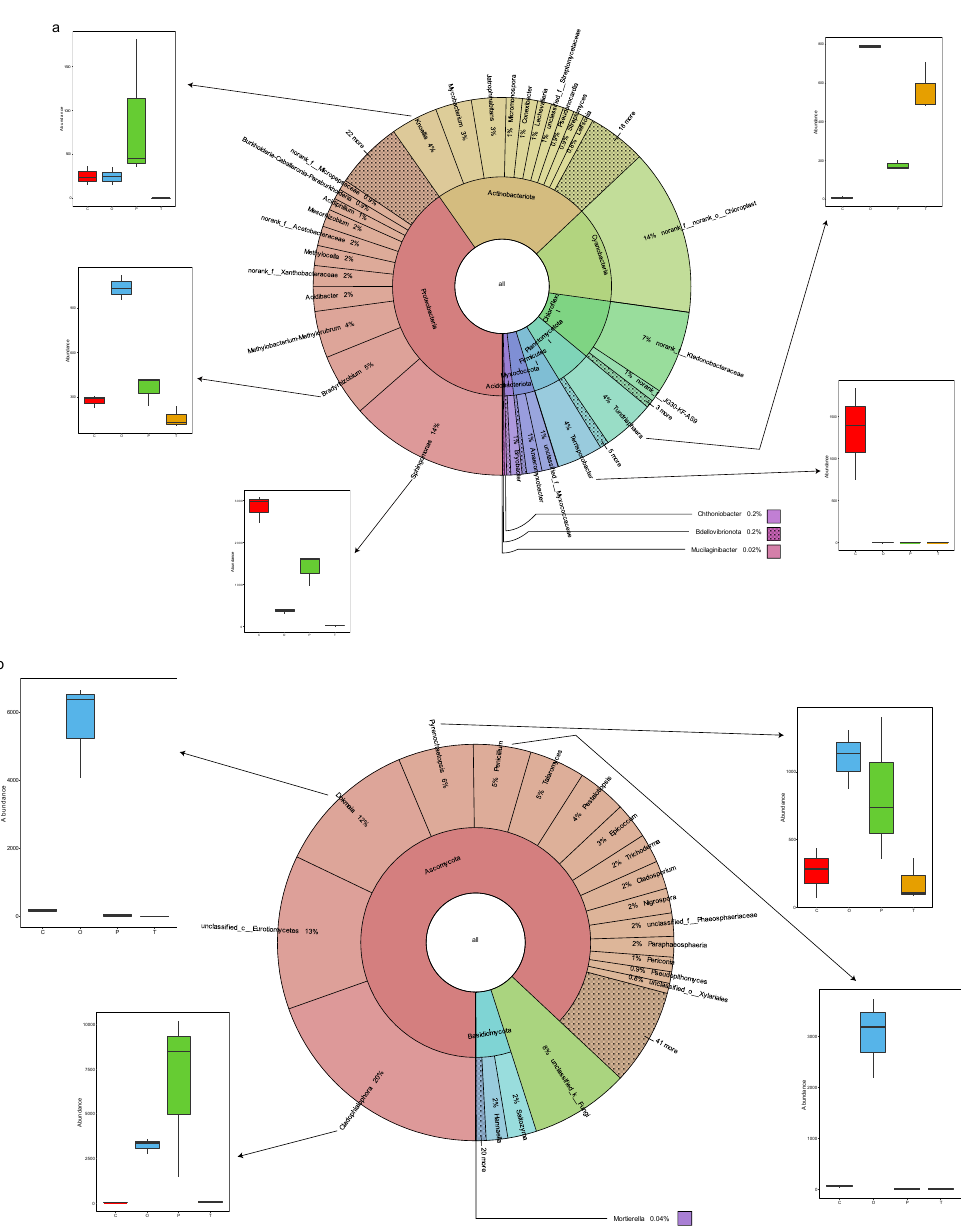
Figure 8. Core microbiome of moss-dominated biocrusts. The different portions within the inner pie chart represent the bacterial ( a ) or fungal ( b ) phyla that are part of the moss core microbiome. The outer donut plot represents the genera that are part of the core, and each genus assigned to the phylum they belong to. The size of the different pie and donut portions represents the contribution of each phylum/genus to the total relative abundance. Satellite box plots depict the relative abundance of selected genera by moss accession (C, O, P, T). Red color was assigned to C; cyan to O; green to P; yellow to T soil, respectively. C: Claopodium rugulosifolium ; O: Orthotrichum courtoisii ; P: Polytrichum formosum ; T: Taxiphyllum giraldii .